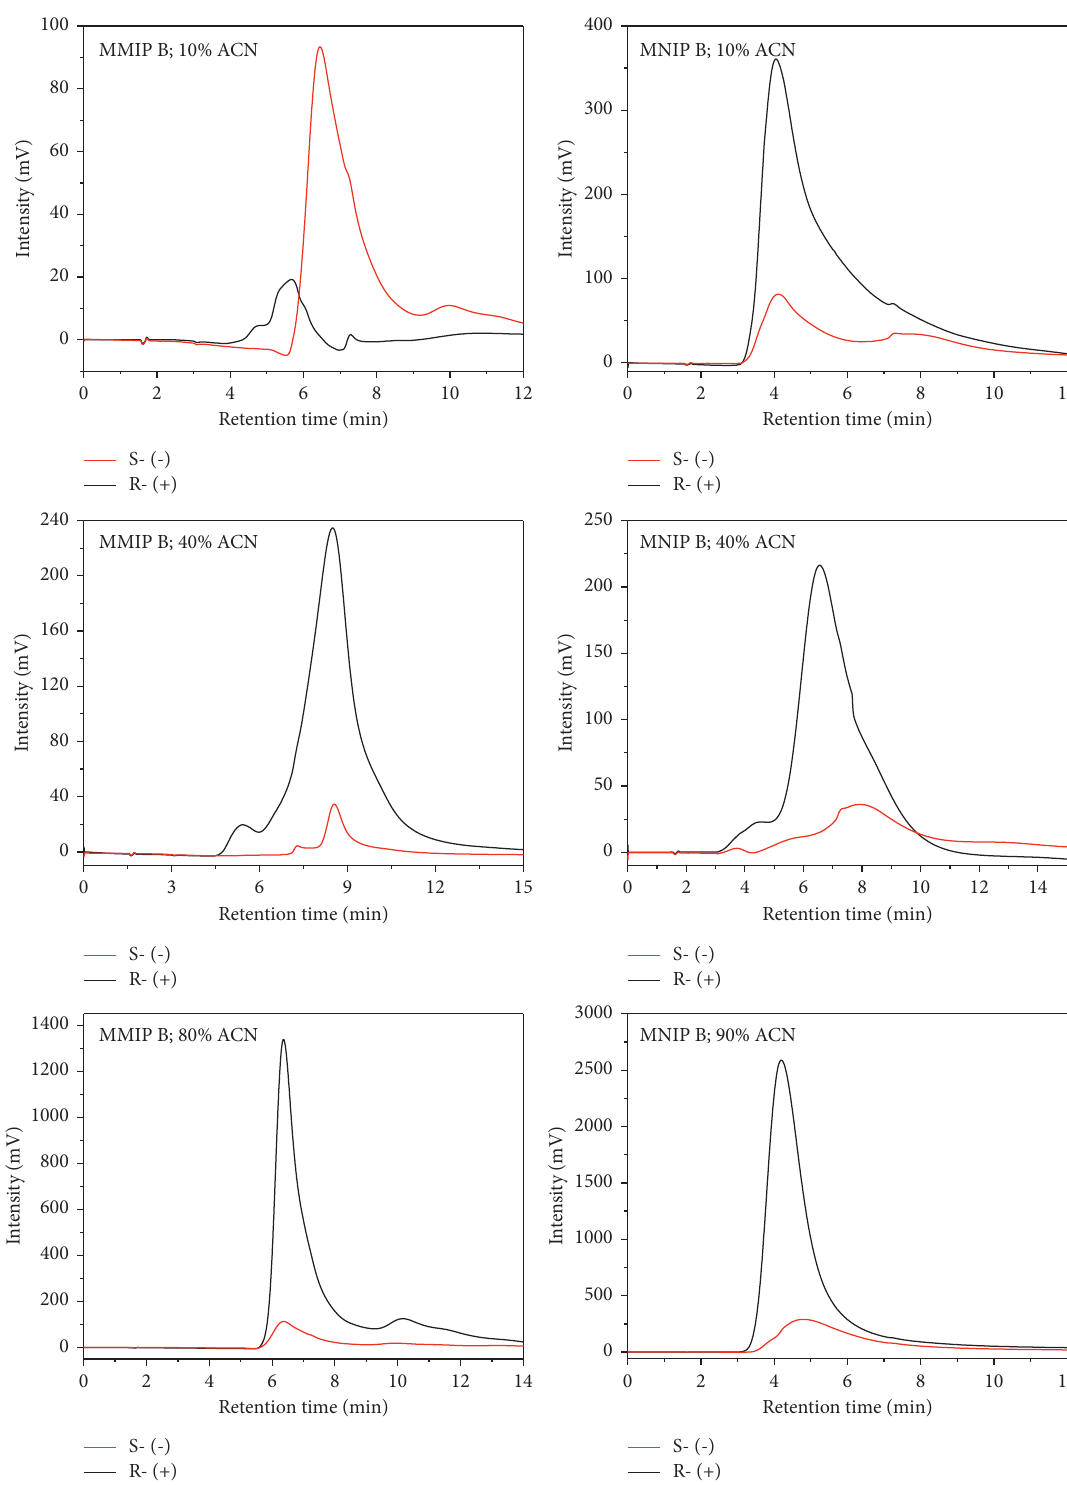
Figure 8: The effect of ACN concentration in water as the mobile phase to the retention time of (R)-(+)-citronellal and (S)-( − )-citronellal with MMIP B and MNIP B columns with the flow rate of